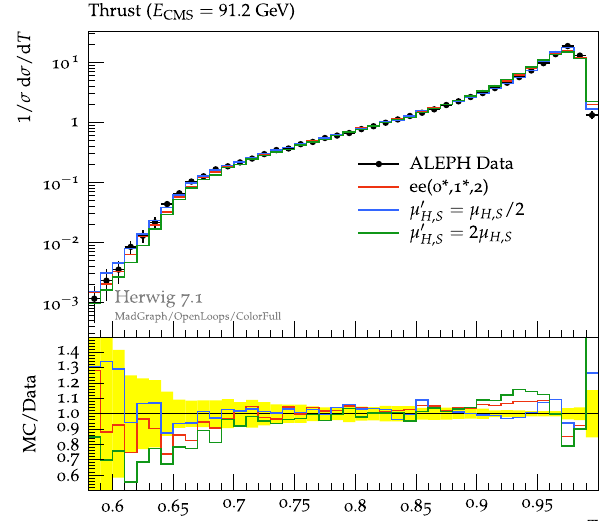
Fig. 13 Including NLO corrections for the production process and one additionalemissionprocess, ee ( 0 ∗ , 1 ∗ , 2 ) ,reducesthescalevariationof the thrust distribution. Here we compare to data from ALEPH [64]. The uncertainty bands do not cover the variations produced by changing the schemes described in Sect. 6.6. Observables more sensitive to multiple emissions are still showing large error bands